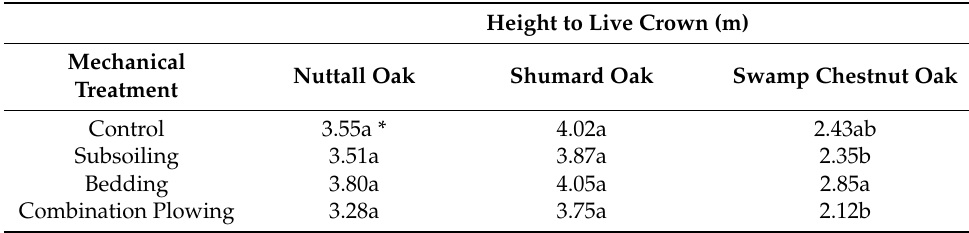
Table 3. Analysis of height to live crown of oak trees by species and mechanical site preparation treatment at 11 years